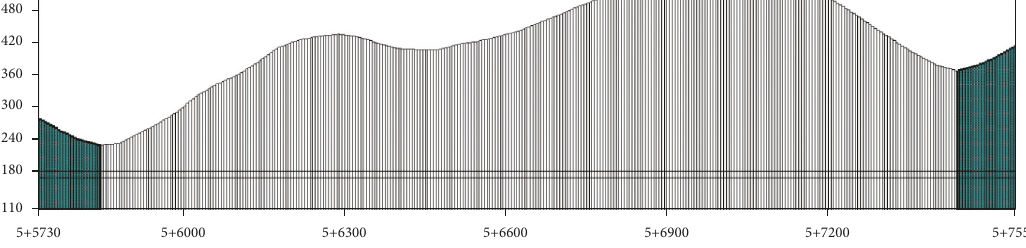
Figure 3: Vertical section of the